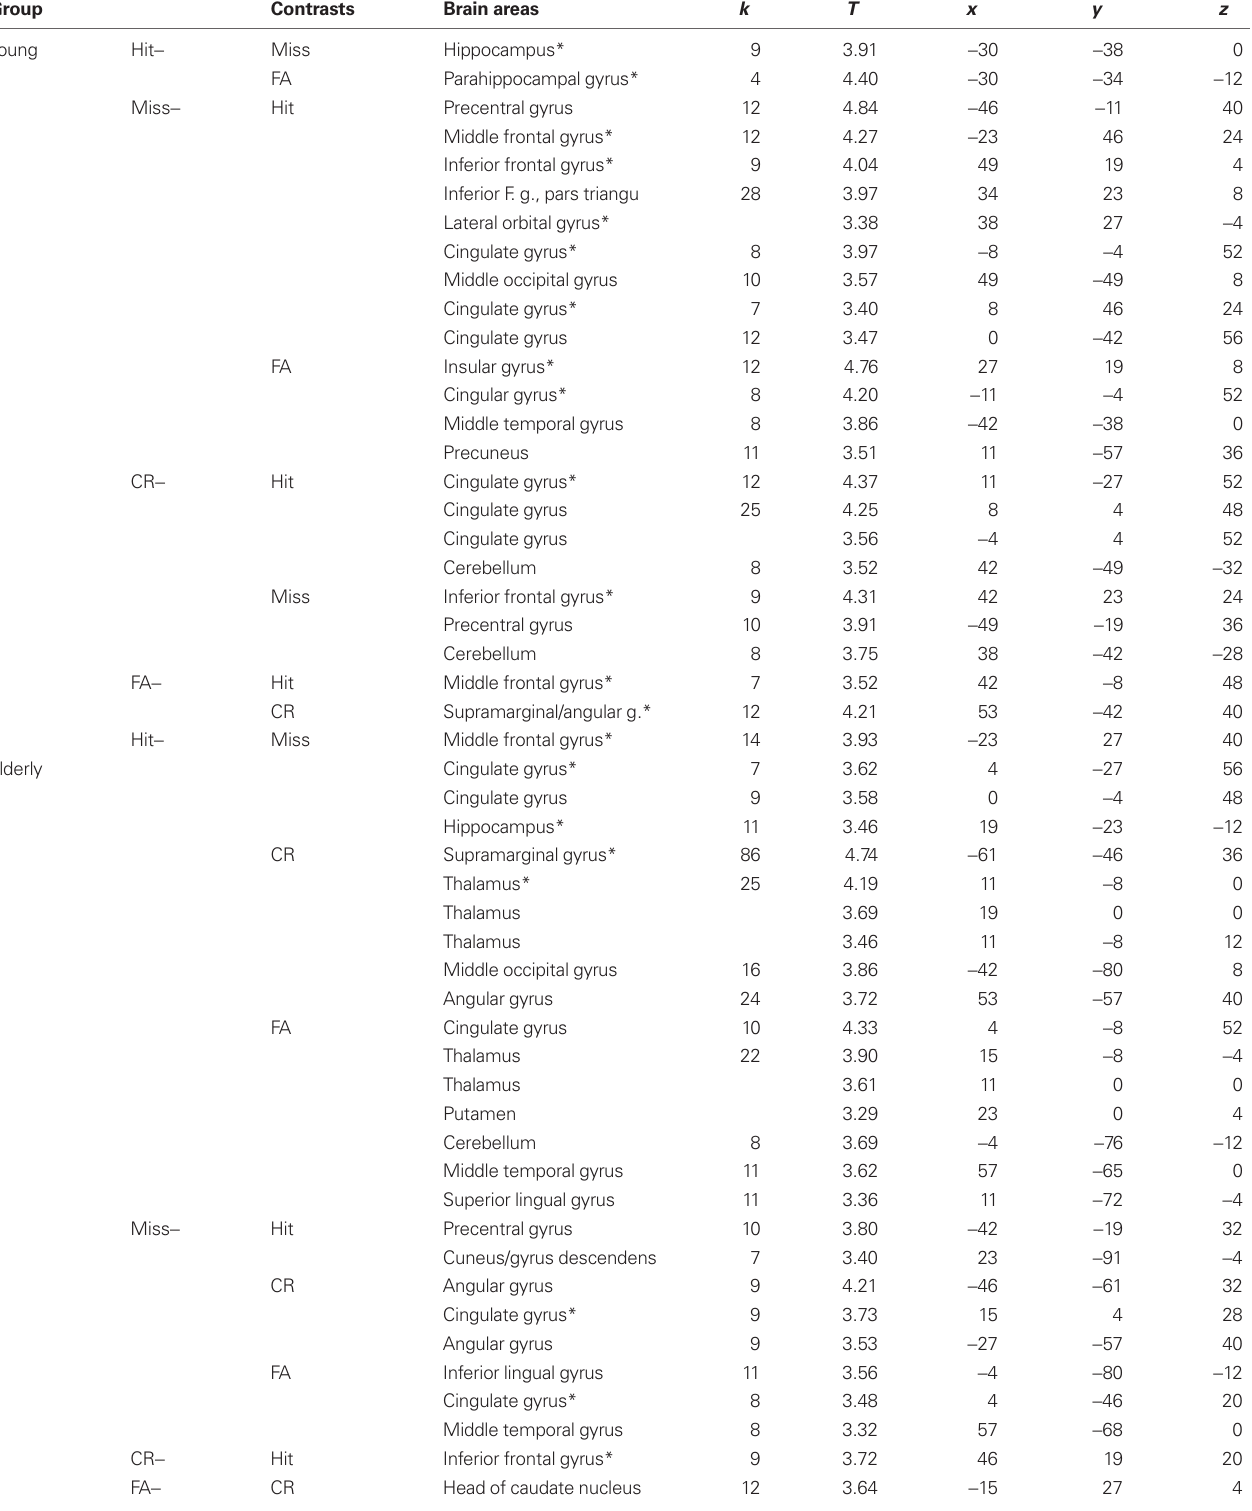
Table 3 | Brain areas activated as a function of contrasts between response categories. group Contrasts Brain areas k Young Hit